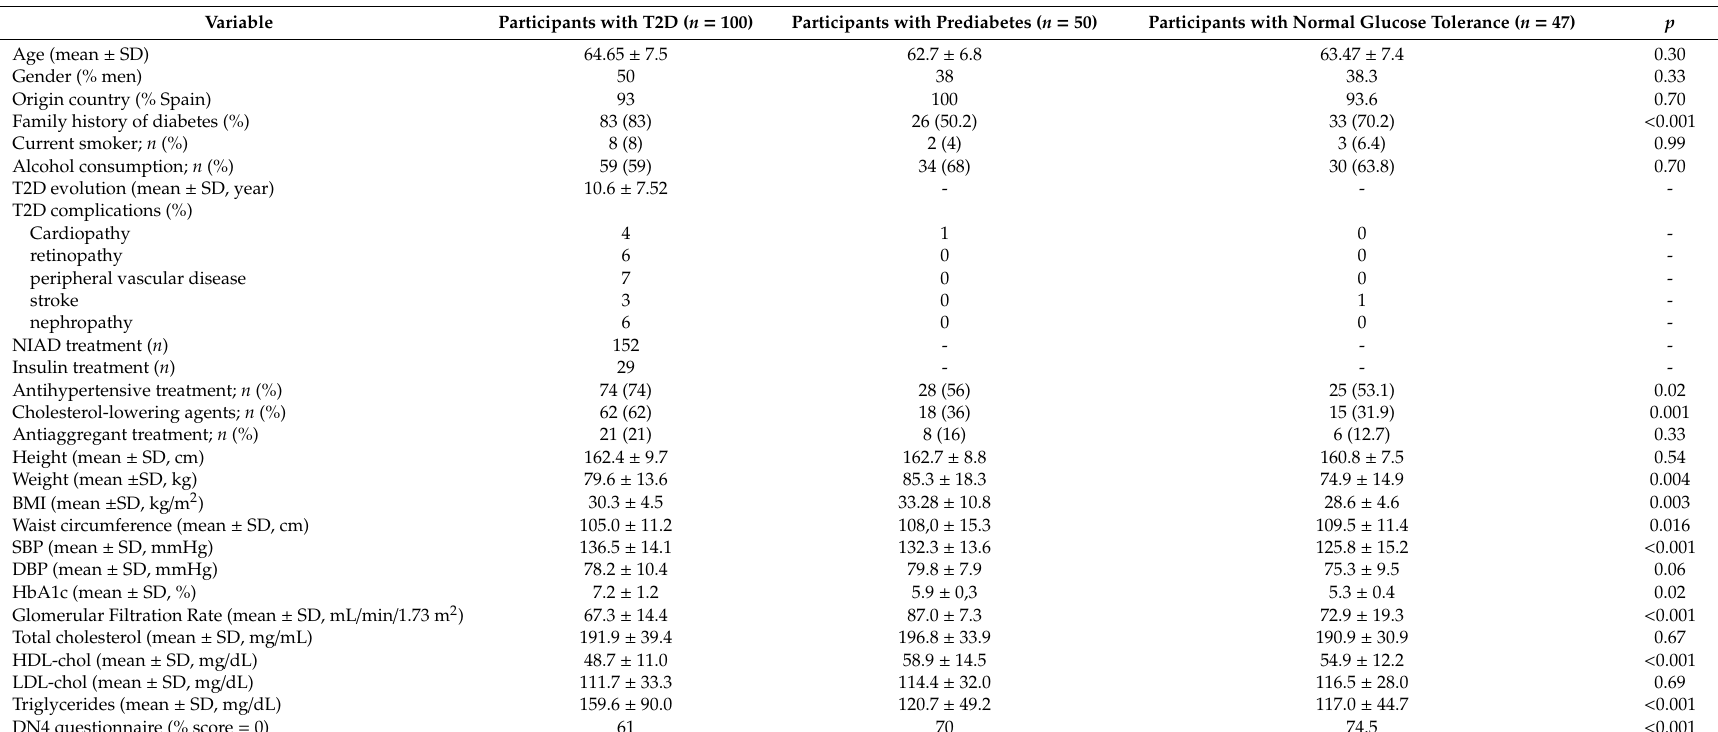
Table 1. Sociodemographic and clinical data of the study participants (type 2 diabetes (T2D), prediabetes and normal glucose